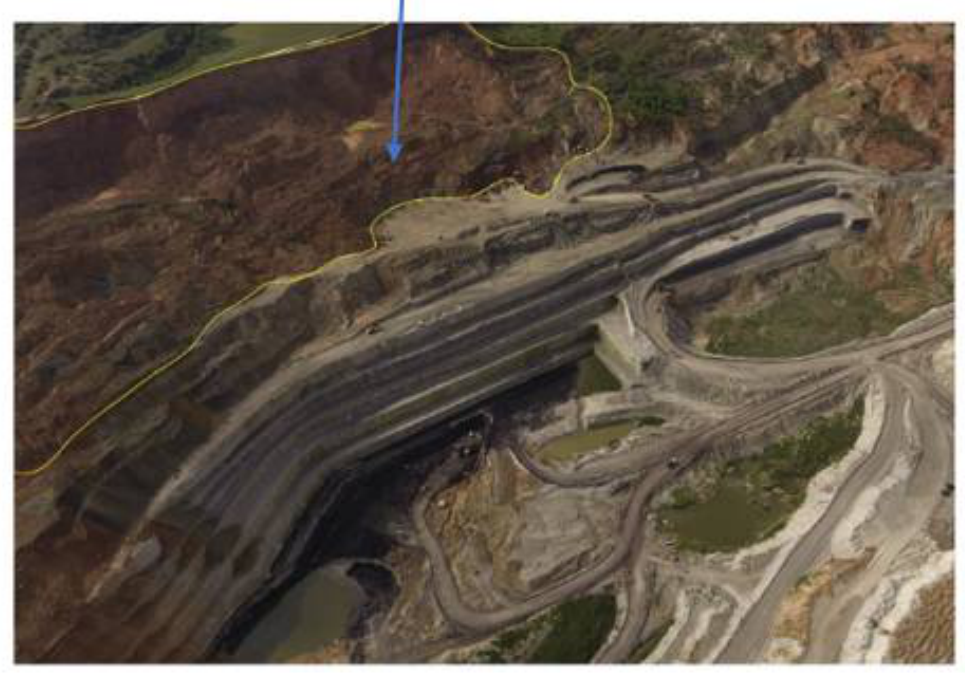
Figure 13. Sliding portion of lava lignite mine in Greece (Adapted from [106]).